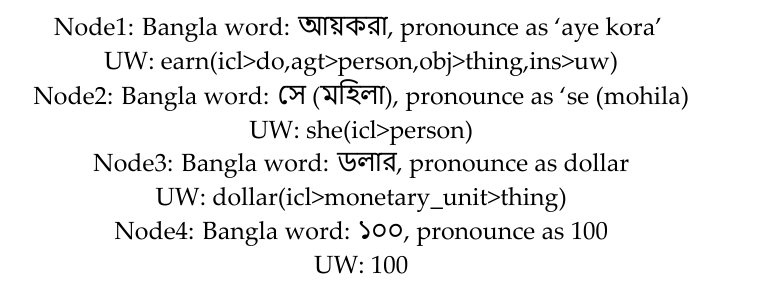
Figure 6. UNL graph for the UNL expression (9).